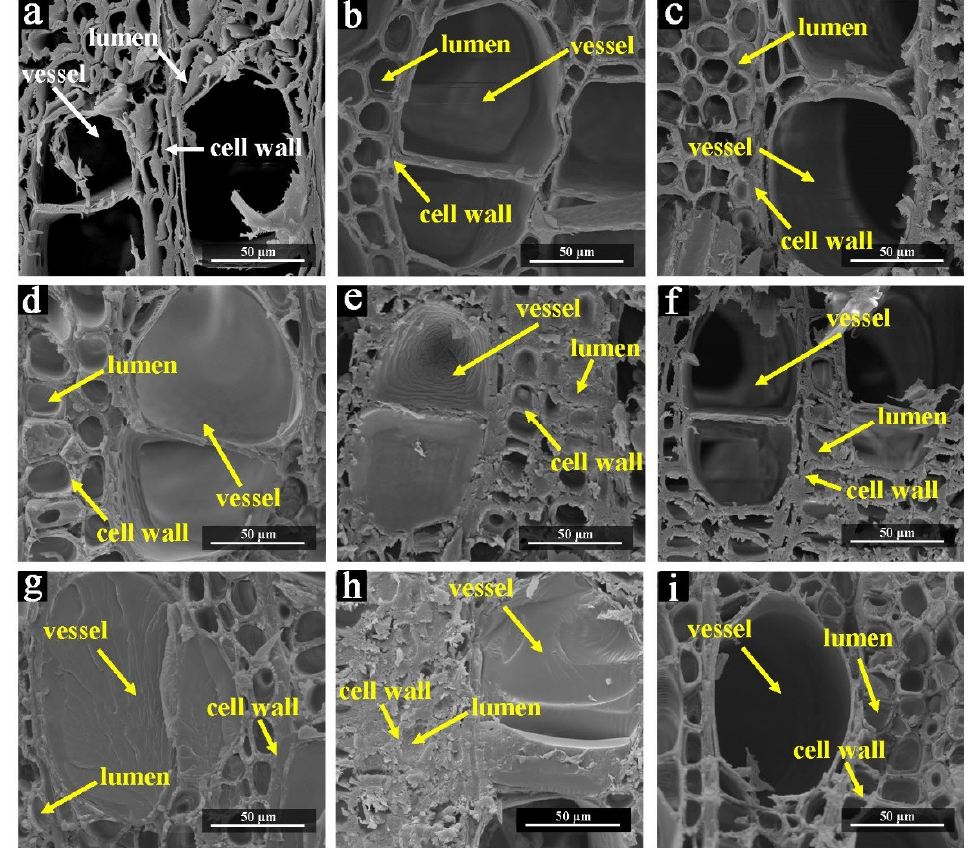
Figure 6. The SEM of unmodified veneer and FA-modified veneer (G1–G8) ( a ) unmodified veneer; ( b ) G1; ( c ) G2; ( d ) G3; ( e ) G4; ( f ) G5; ( g ) G6; ( h ) G7; ( i ) G8. ( b ) G1; ( c ) G2; ( d ) G3; ( e ) G4; ( f ) G5; ( g ) G6; ( h ) G7; ( i )